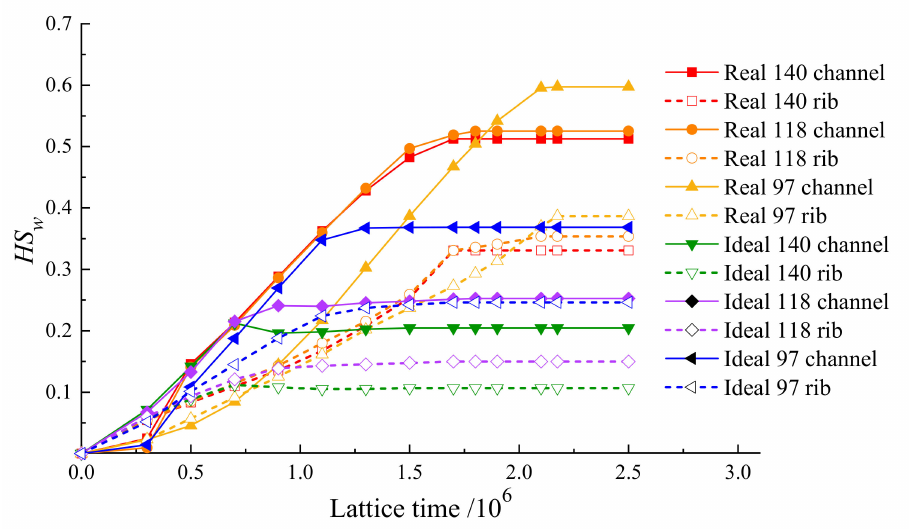
Figure 6. HS w in the GDL with different hydrophobicity in real GDL and ideal